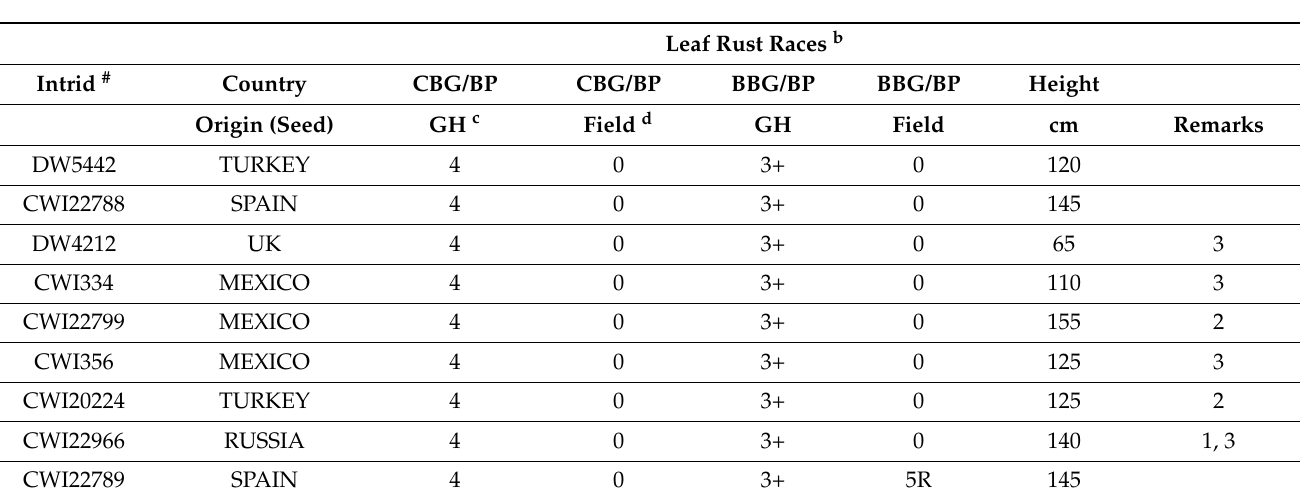
Table 4. Infection types a at seedling, final disease severity in the field in response to two leaf rust races, and plant height of selected seedling-susceptible adult plant-resistant winter or facultative tetraploid